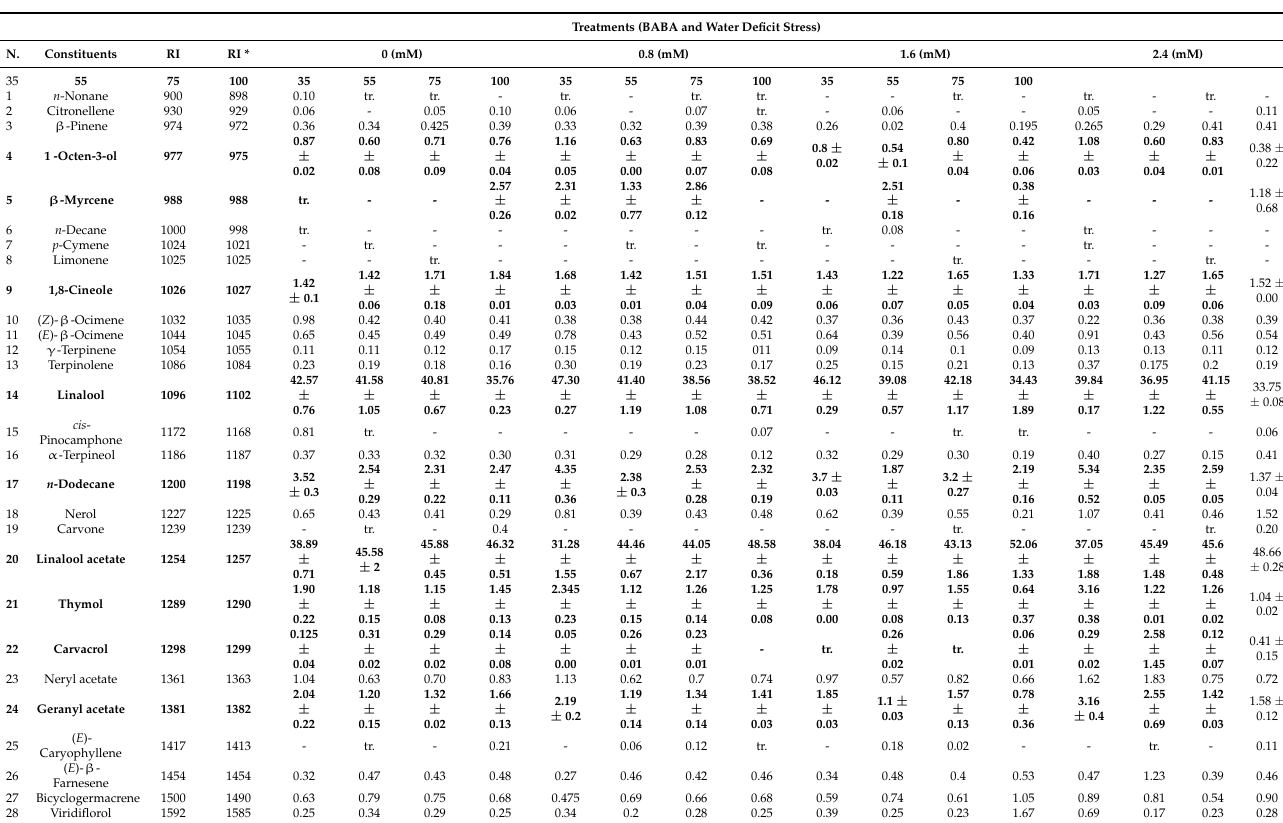
Table 4. Grapefruit mint essential oil compositions under different levels of water stress and BABA